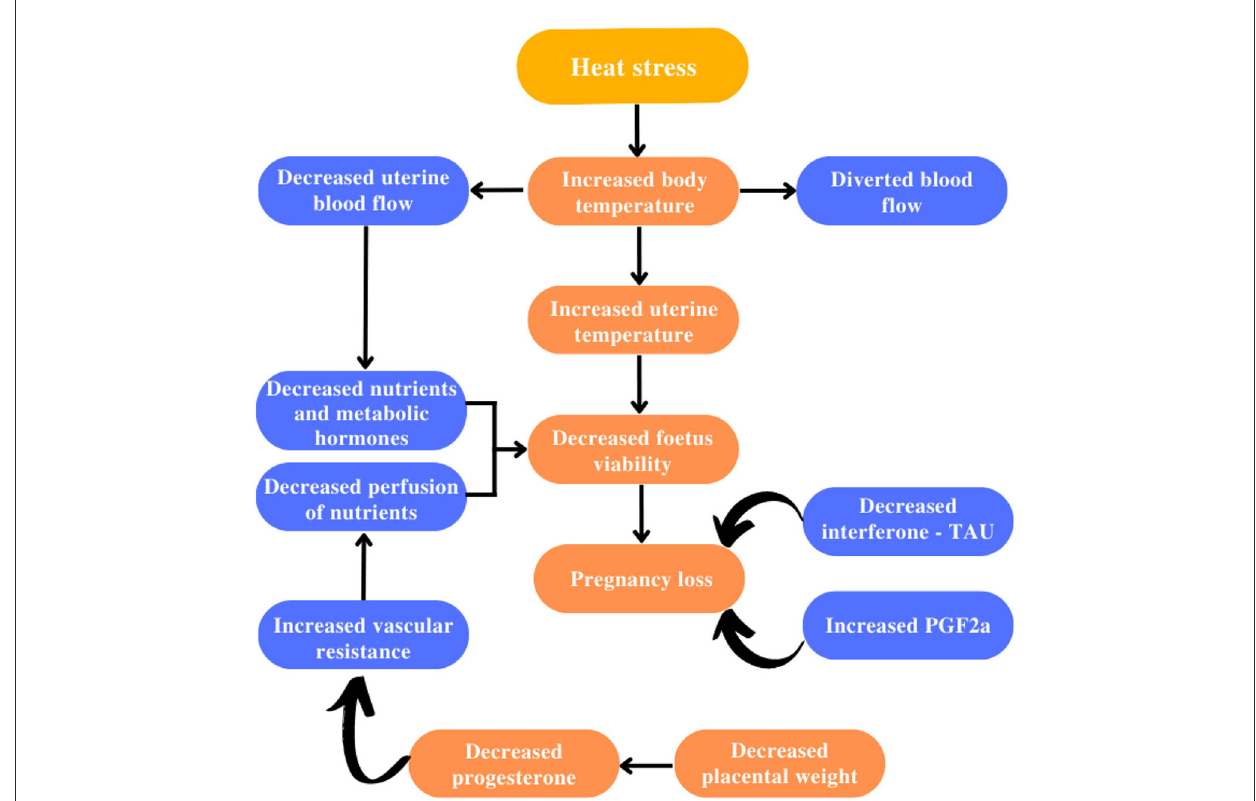
FIGURE6 Aspects of the main impacts caused by heat stress during cattle handling. Adapted from Krishnan et al. (37).